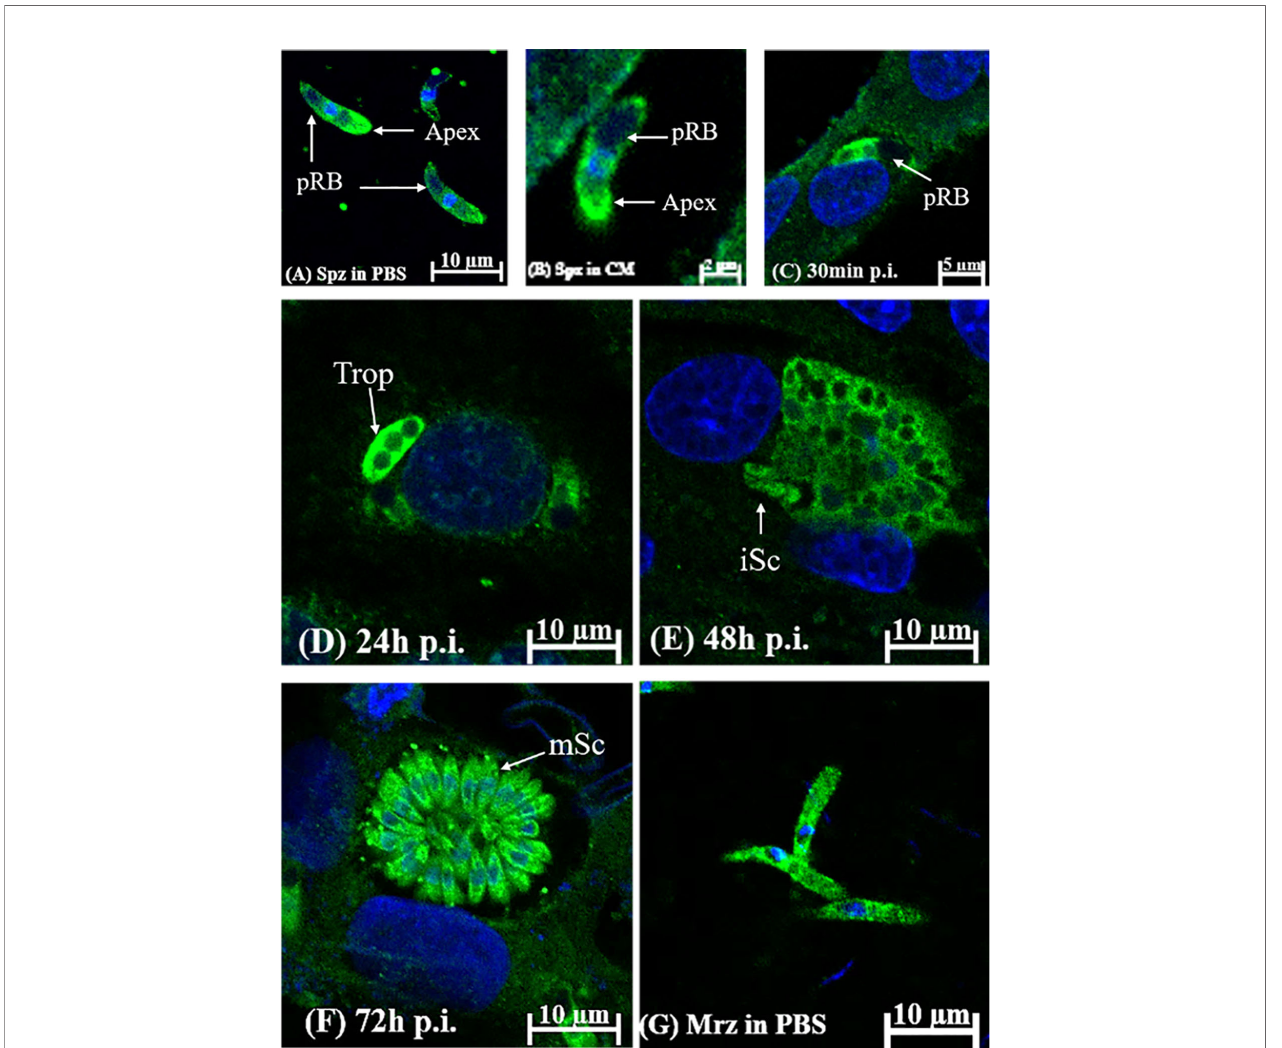
FIGURE 8 | Localization of Et eIF-5A in different developmental stages of Eimeria tenella by indirect immuno fl uorescence using rabbit anti-r Et eIF-5A IgG. (A) sporozoites (Spz) in phosphate-buffered saline (PBS); pRB, posterior refractile body. (B) sporozoites in complete medium. DF-1 cells were collected at the indicated time points post-infection (p.i.). (C) sporozoites at 30 min p.i.; (D) trophozoite (trop) at 24 h p.i.; (E) immature schizont (iSC) at 48 h p.i.; (F) mature schizont (mSc) at 72 h p.i.; (G) merozoites (Mrz) in PBS.